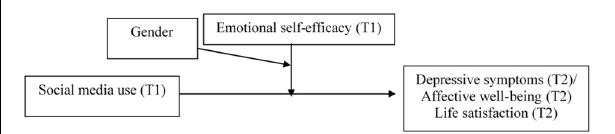
FIGURE 1 | The hypothesized three-way interaction